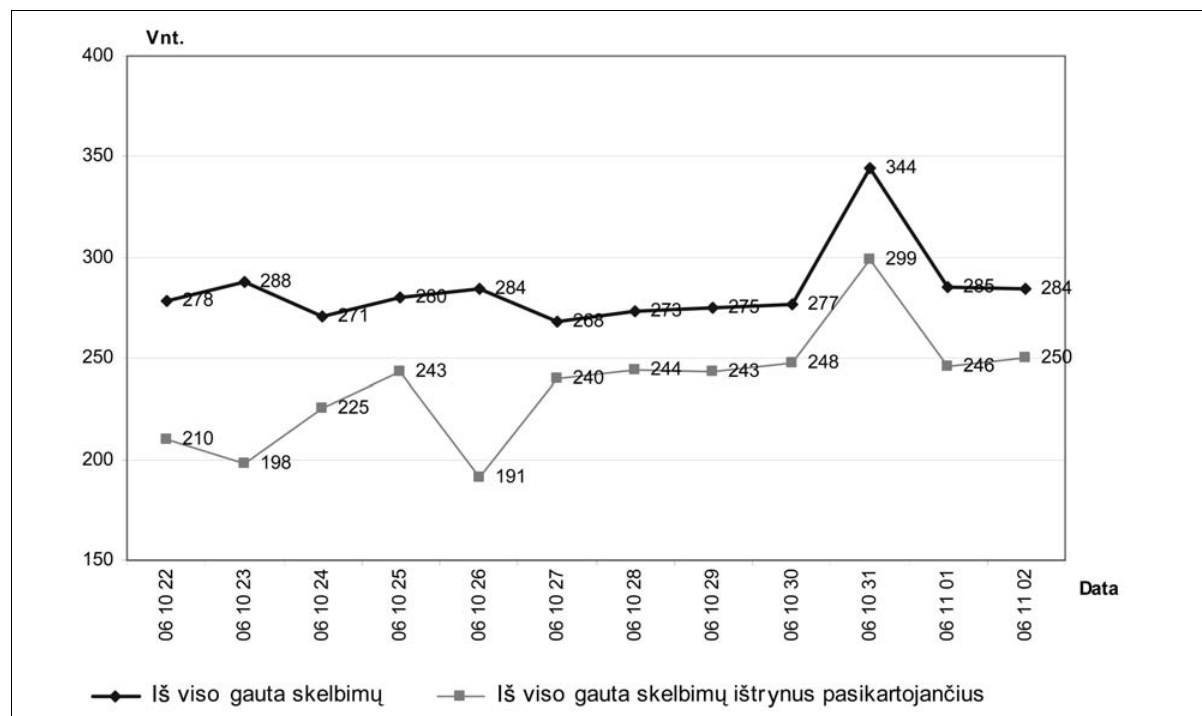
Fig 6. Results of the